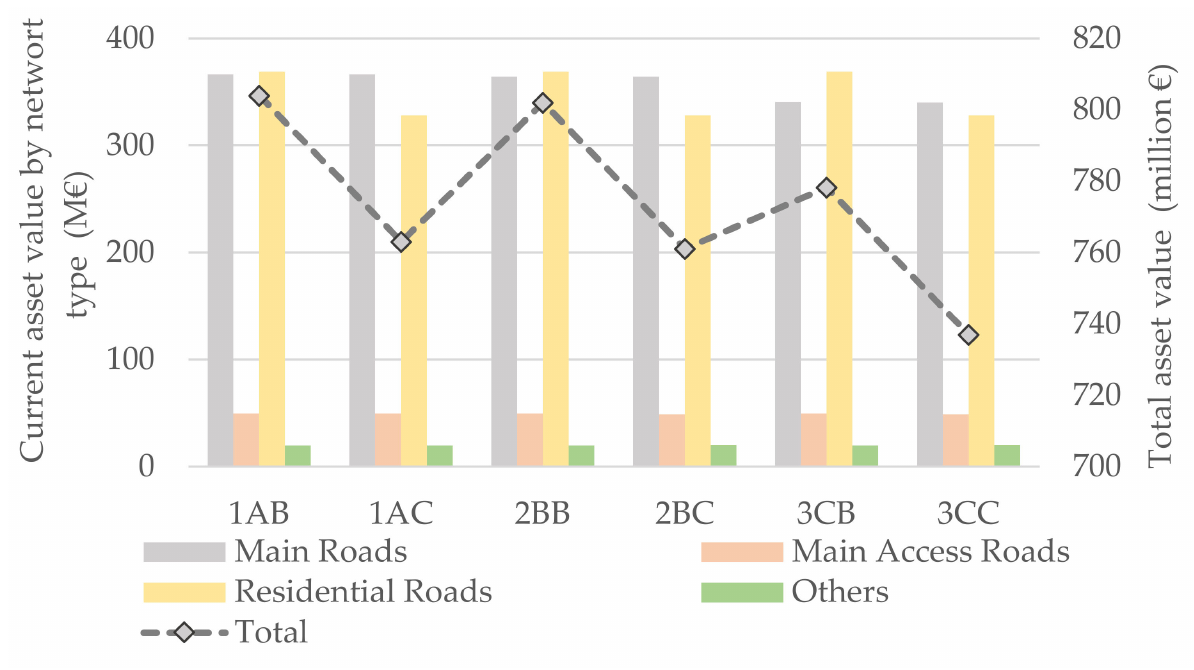
Figure 3. Asset value of the road network for the different